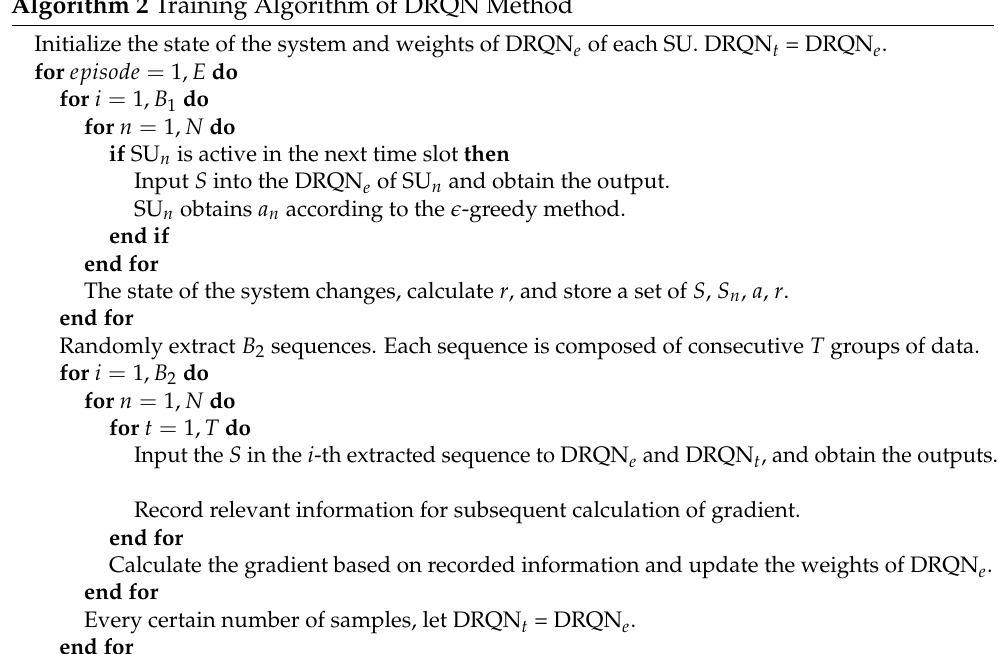
Algorithm 2 Training Algorithm of DRQN